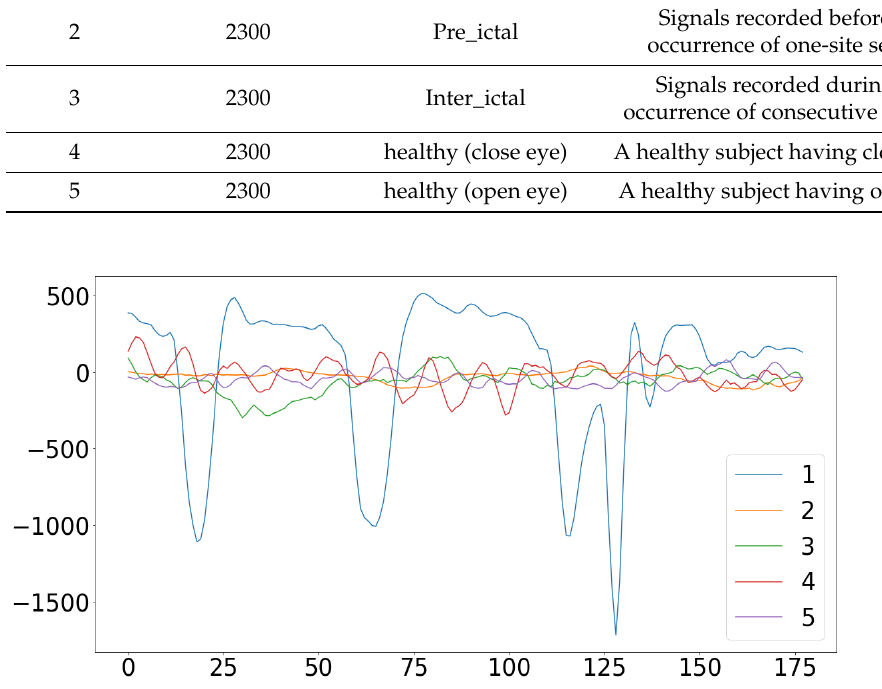
Figure 3. EEG Waveform of four normal conditions vs. one epileptic